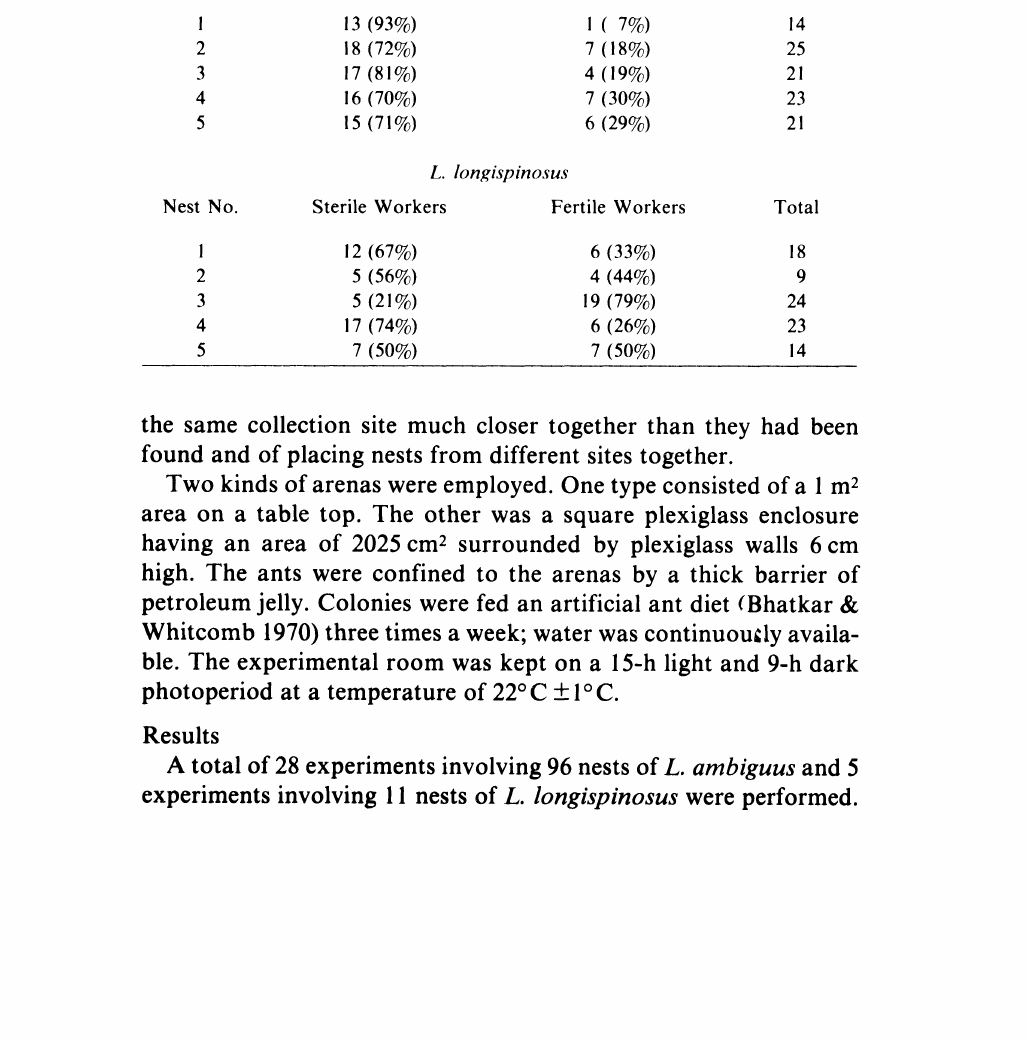
Table 9. Numbers and Percent of Sterile and Fertile Workers in Queenless Nests of L. ambiguus, L. curvispinosus, and L. longispinosus L. ambiguus Nest